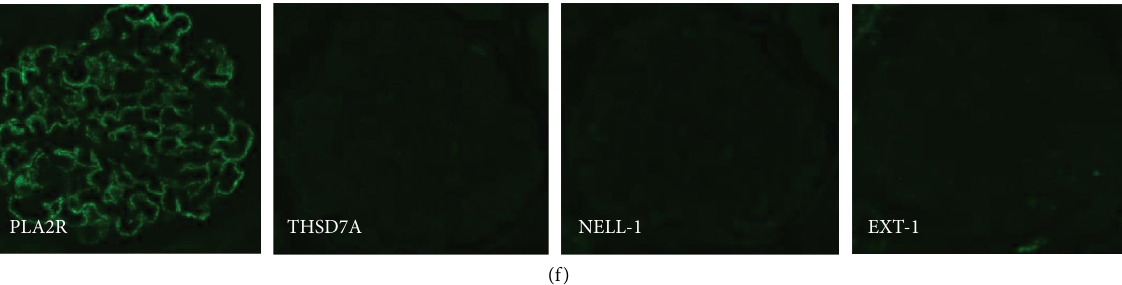
Figure 3: Renal biopsy fndings. Periodic acid schif (PAS) staining shows no obvious mesangial proliferation, crescent, or focal adhesions (a). Periodic acid methenamine silver (PAM) staining shows spikes and bubbling in the basement membranes (b). Electron microscopy reveals subepithelial and intramembrane deposits of homogenous sizes and stages and mild subendothelial enlargement (c). Immuno- fuorescent fndings show marked granular deposit of IgG, IgA, and IgM, but no staining for complement (d). We examined depositions of IgG subclasses (e) and several MN-associated antigens as follows: phospholipase A2 receptor (PLA2R), thrombospondin type-1domain- containing 7A (THSD7A), neural epidermal growth factor-like 1 (NELL-1), and exostosin-1 (EXT-1) (f).